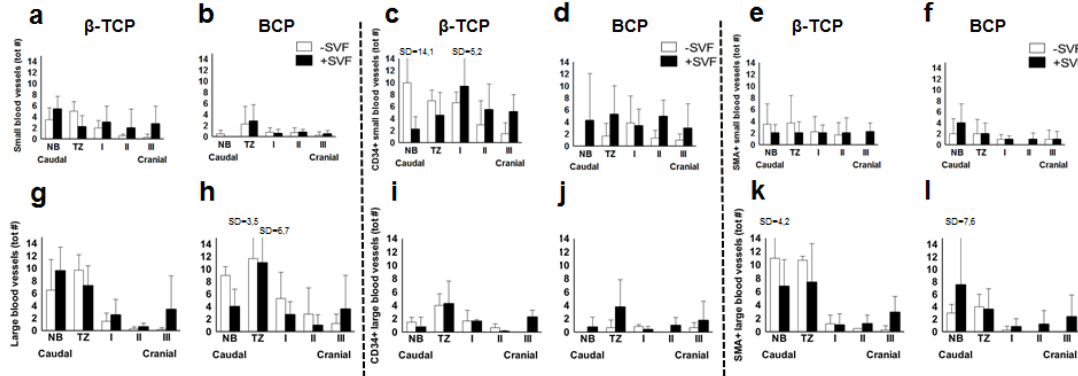
Figure 5. Histomorphometrical analysis of the absolute number of small and large blood vessels from maxillary bone biopsies in patients treated with β -TCP ( a , g ) and BCP ( b , h ) with stem cells (black bars, n = 5) and without stem cells (white bars, n = 3). The total number of CD34+ small and large blood vessels from maxillary bone biopsies in patients treated with β -TCP ( c , i ) and BCP ( d , j ) with stem cells (black bars, n = 5) and without stem cells (white bars, n = 3). The total number of SMA+ small and large blood vessels from maxillary bone biopsies in patients treated with β-TCP ( e , k ) and BCP ( f , l ) with stem cells (black bars, n = 5) and without stem cells (white bars, n = 3). See the legend to Figure 2 for the definitions of regions I-III. β-TCP, β-tricalcium phosphate; BCP, biphasic calcium phosphate; NB, Native bone; TZ, transition zone; SVF, stromal vascular fraction; tot #, total number.